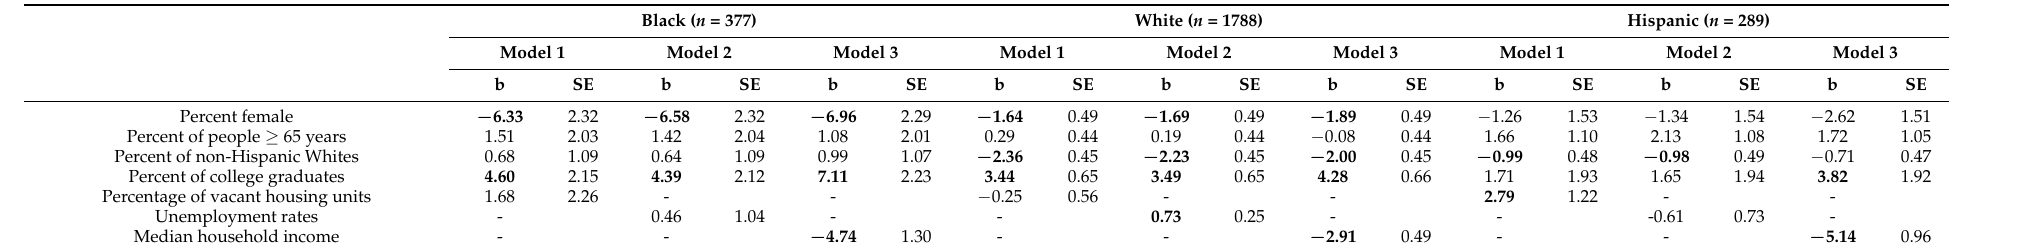
Table 4. Association between county economic changes and changes in county drug mortality rates from 2004–2007 to 2016–2019: Race/ethnicity-specific mortality